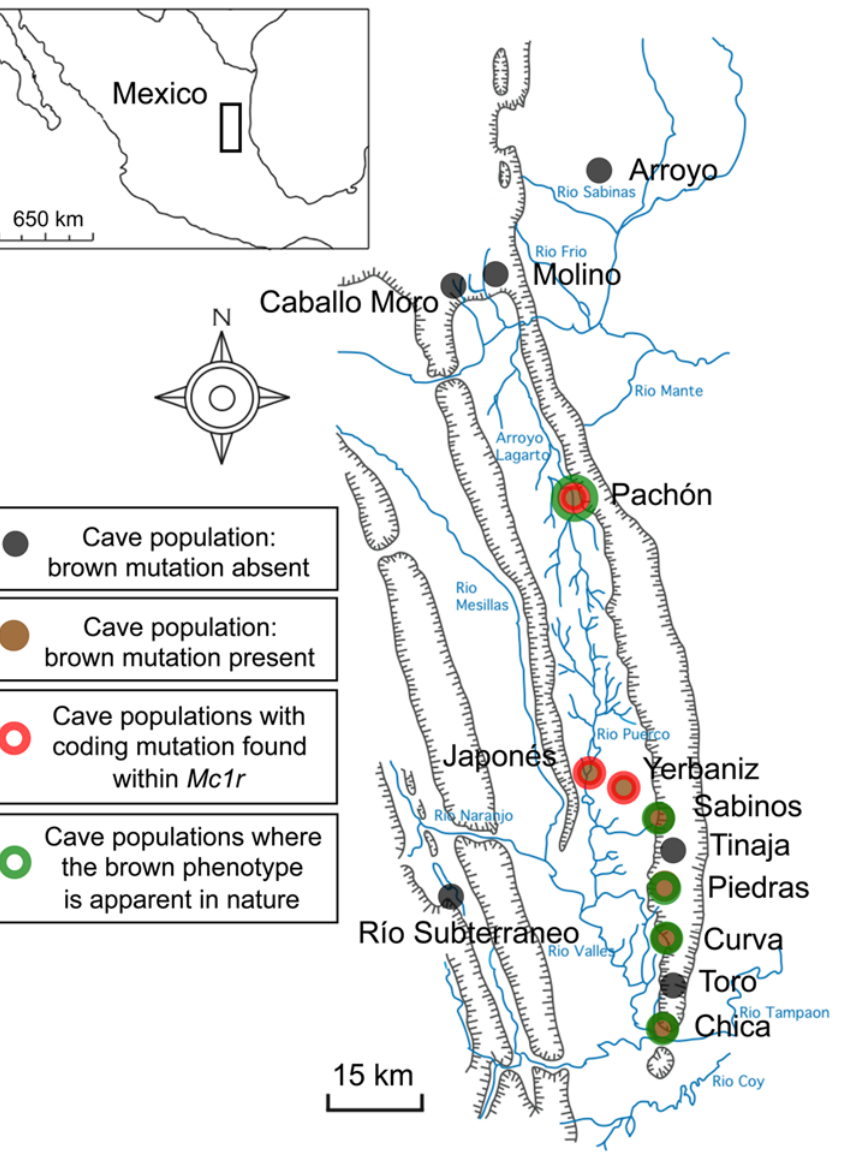
Figure 1. Schematic map and localities of cave and Surface populations of the Mexican tetra, Astyanaxmexicanus . Several cave and Surface populations have been described throughout the Sierra de el Abra region of northeastern Mexico (inset). Cave populations in which the brown mutation is either absent (Molino cave) or has not been described (Tinaja cave) are depicted by a black dot. Cave populations in which the brown mutation has been described are denoted by a brown dot, while populations housing the brown mutation and carrying coding mutations in the gene Mc1r are depicted by a red/brown dot. Cave localities in which the brown phenotype is apparent in nature are labeled in green. Most localities do not harbor albinism (e.g., Chica, Curva, Piedras and Sabinos) and therefore, the phenotypic expression of the brown mutation in nature is inferred in these caves. Caves in which albinism has been reported include the Molino, Pacho´n, Yerbaniz and Japone´s populations. Interestingly, of these caves only the Molino cave does not also harbor the brown mutation. While brown individuals have been reported in the Pacho´n cave [18], the same has not been reported in the literature in fish derived from the albino Yerbaniz/Japone´s cave populations. Surface populations of Astyanax are found widely present throughout the rivers and streams of the region. Reports of the brown mutation and map of localities adapted from [4,16,18,88–90].